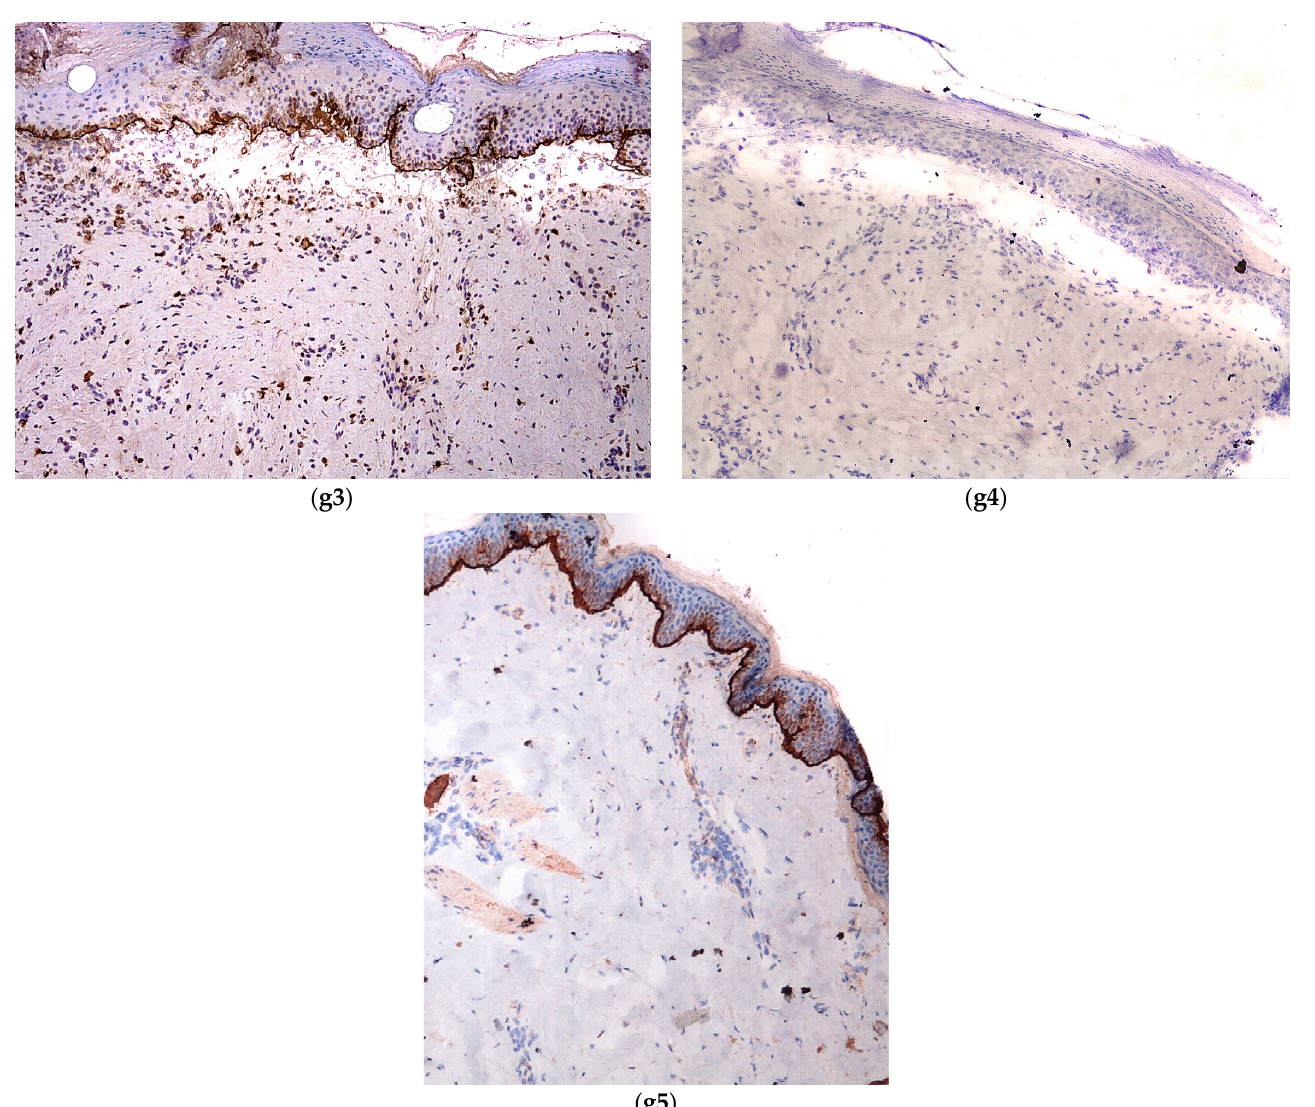
Figure 5. Hereditary epidermolysis bullosa. ( a ) Generalised blisters in EBS. ( b ) Cutaneous aplasia in EBJ. ( c ) EBS: intraepidermal cleavage. ( d ) EBJ: cleavage in lamina lucida. ( e ) EBD: cleavage in anchoring fibrils. ( f ) EB simplex: ( f1 ) Hematein eosin ×10: blister at the DEJ with vacuolization of basal keratinocytes (arrows) and remnants of basal keratinocytes (asterisk) on the floor of the blister; ( f2 ) immunohistochemistry with anti ‐ pan cytokeratin antibody showing positivity on the roof and the floor of the blister; ( f3 , f4 ) immunohistochemistry with anti ‐ laminin and anti ‐ collagen VII antibodies showing positivity on the floor of the blister. ( g ) Dystrophic EB: ( g1 ) Hematein eosin X10 blister at the DEJ; ( g2 ) immunohistochemistry with anti ‐ pan cytokeratin antibody showing positivity on the roof of the blister; ( g3 ) immunohistochemistry with anti ‐ laminin showing positivity on the roof of the blister; and ( g4 ) anti ‐ collagen VII antibodies showing absence of expres ‐ sion compared to a control ( g5 ).